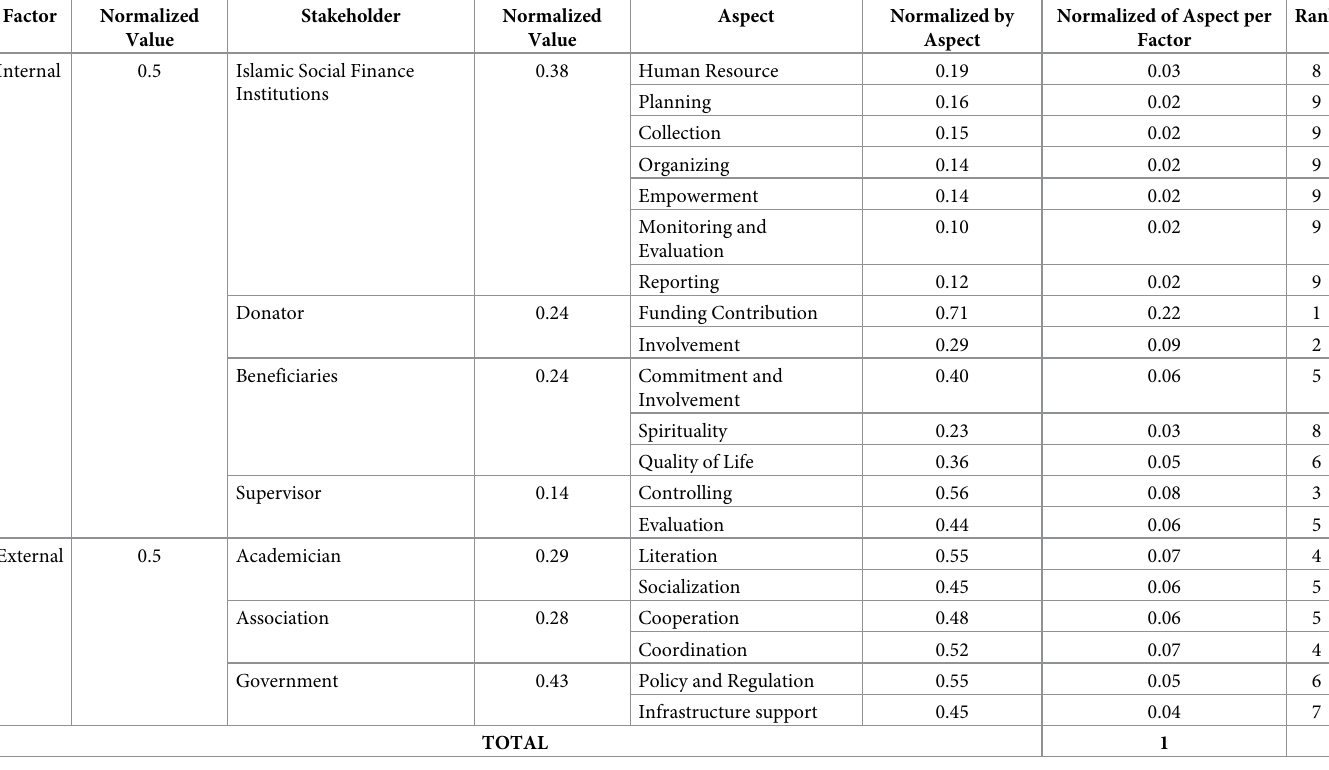
Table 4. Data processing results of success and sustainability index of Islamic Social Finance program. Factor Normalized